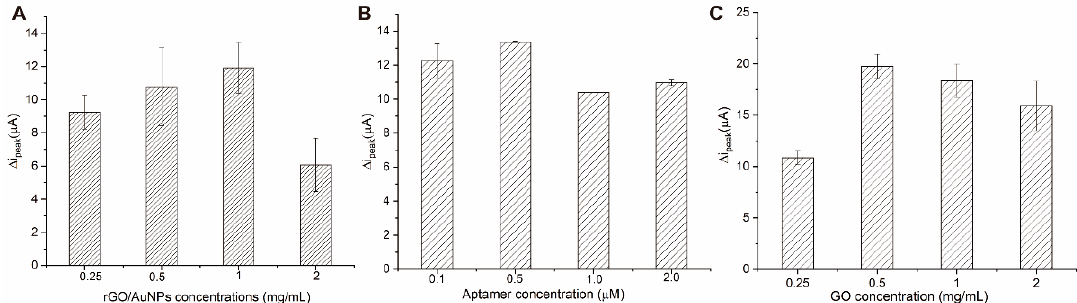
Figure 4. The effect of different factors: concentrations of ( A ) rGO/AuNPs; ( B ) APT; ( C ) GO on the response of electrochemical aptasensor.